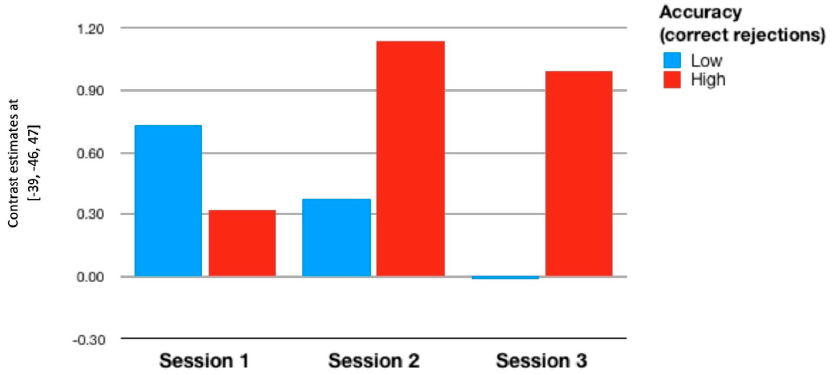
Figure 4. Contrast estimates in superior parietal lobule depending on the scanning session and accuracy in the N-back task. Contrast 3 (‘Correct vs. Incorrect’). Visualization has been prepared independently of the statistical computations, in which the accuracy variable was kept continuous.